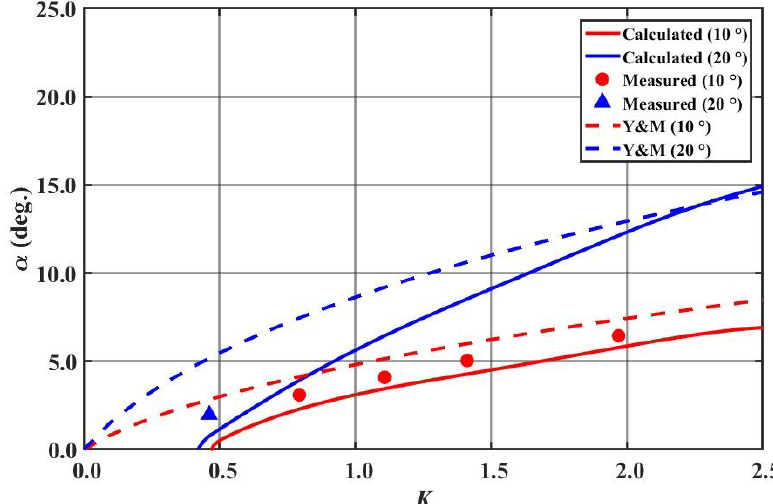
Figure 13. Comparison of calculated and measured stem angle α as a function of nonlinear parameter K . Dashed curves represent the calculated values using Yue and Mei (1980), solid curves are the calculated values using Eq. (12), symbols are measured data. Red and blue colors are for θ 0 = 10 and 20 ◦ , respectively.